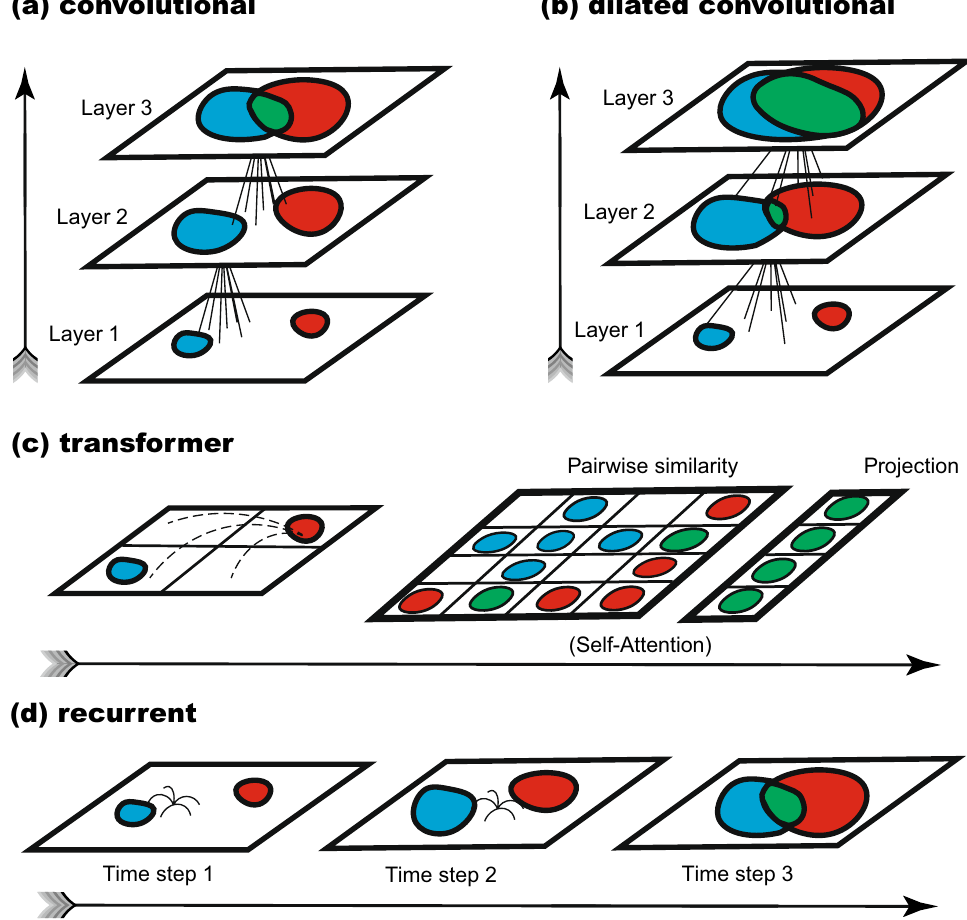
Figure 1. Overview of how the architectures evaluated in this work capture long-range spatial dependencies. We indicate in red and in blue the neurons that are influenced by two different, non-local image regions. Also, we indicate in green the neurons that are influenced by both regions and thus could capture dependencies between them. ( a ) The feed-forward convolutional network uses multiple layers to successively expand the receptive field of convolution operations. ( b ) The dilated convolutional network uses atrous convolutions to expand the receptive field with the same number of parameters. ( c ) Transformer architectures use self- attention layers to conduct a pairwise comparison of pixel blocks. ( d ) Recurrent architectures break long-range dependencies into sequences of local operations that are repeated over many time steps (i.e. unrolling